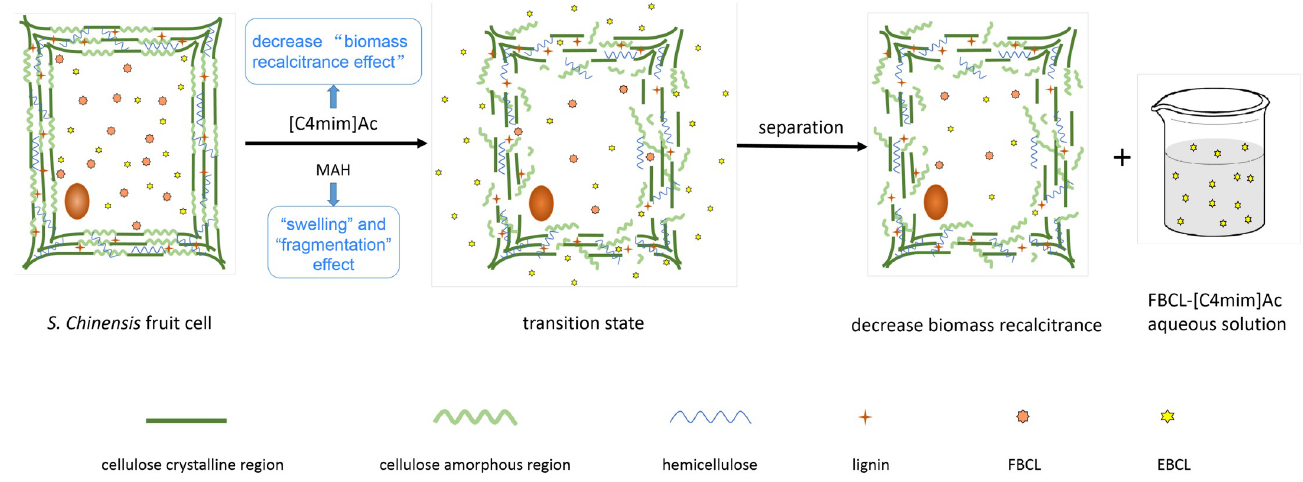
Fig 8. Contributions of an IL and MAH to suppressing the plant cell wall recalcitrance effect.